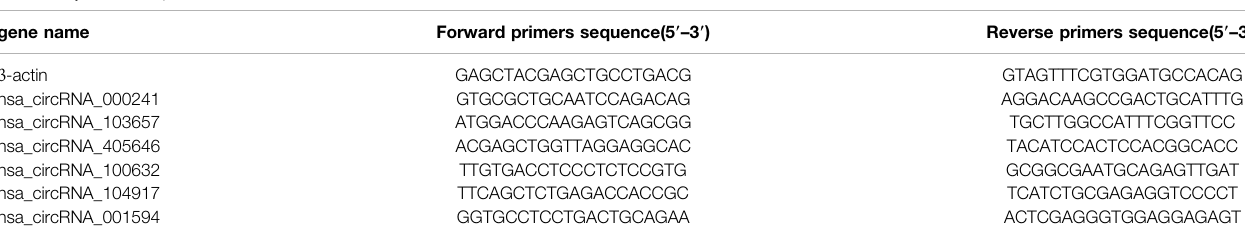
TABLE 1 | Primer sequences used in the validation of